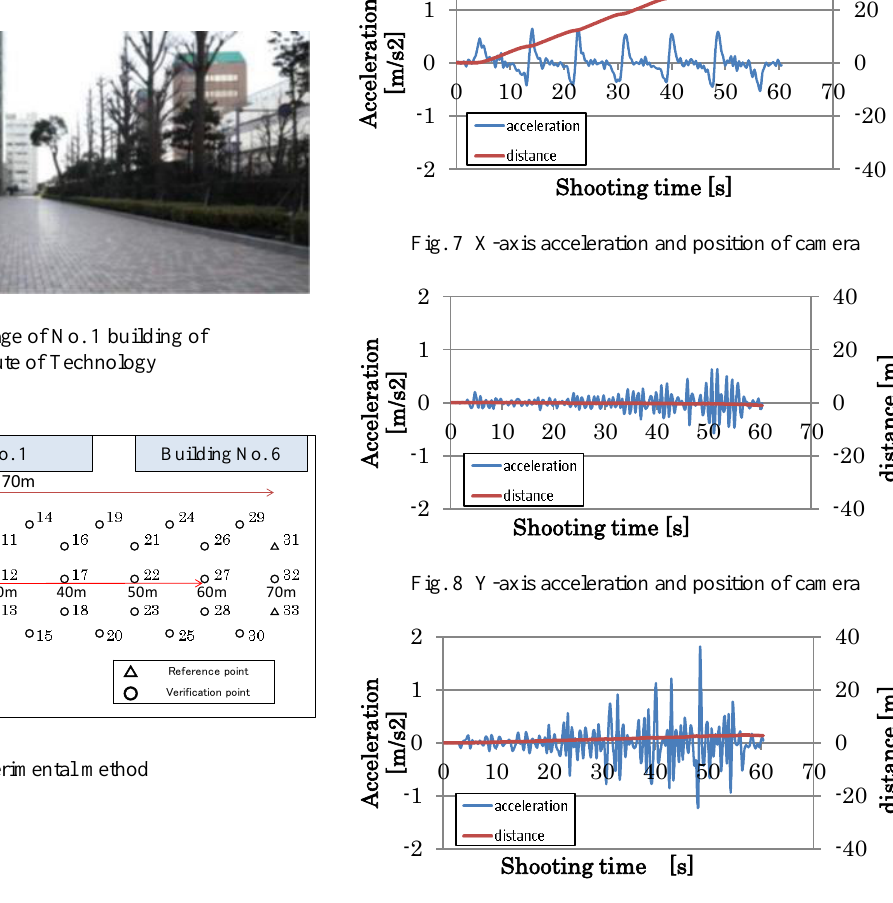
Fig. 9 Z-axis acceleration and position of camera